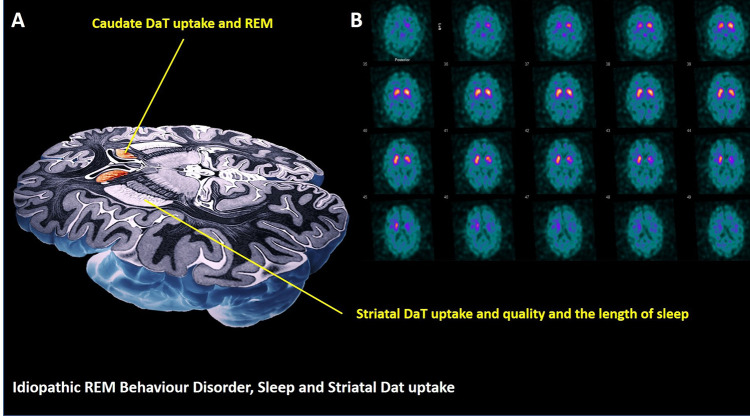
Schematic presentation (A) of links between sleep in iRBD and caudate and putamen DaT uptakes. Serial SPECT images from representative iRBD patient (B) show labelling of the basal ganglia with 123I-FP-CIT.